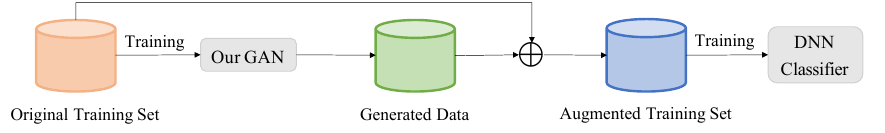
Figure 1. The pipeline of data augmentation in our